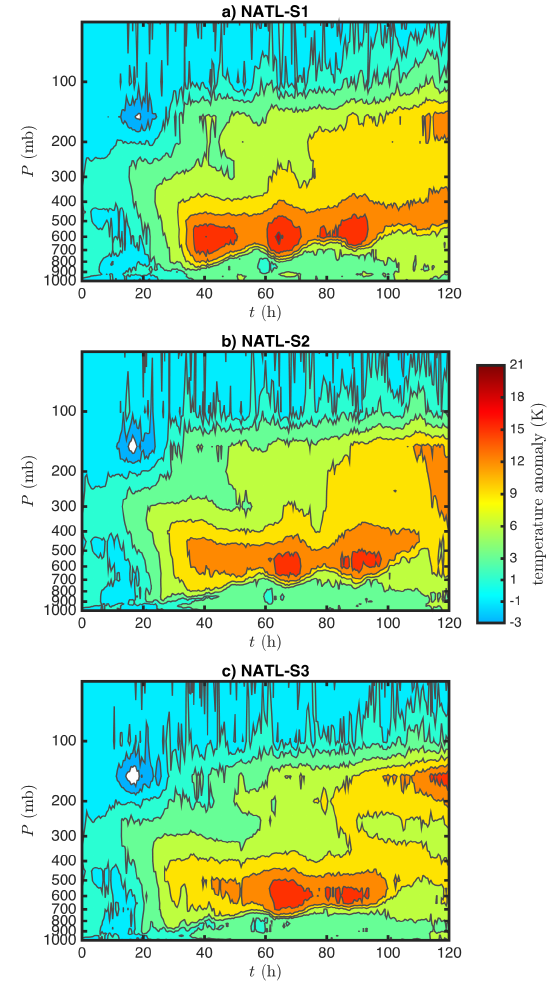
Figure 11. As in Figures 5 and 9 but for the NATL subdomain